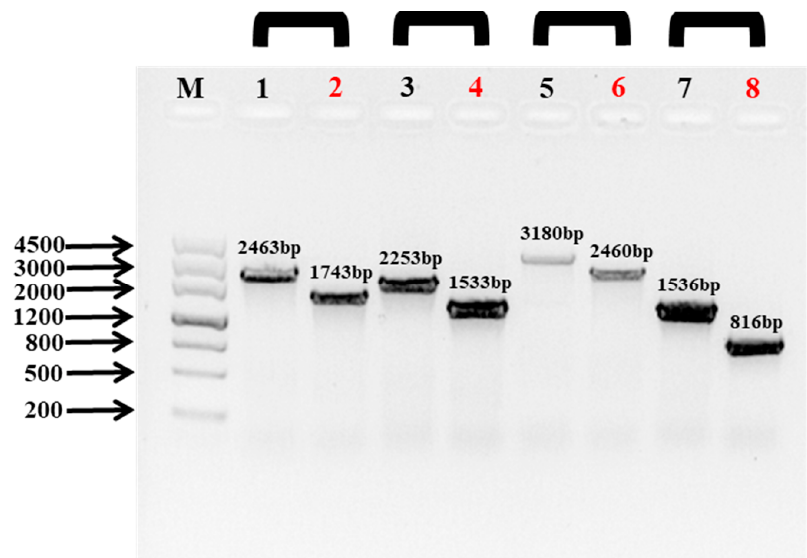
Figure 1. The deletion of the ompR gene was confirmed by PCR. M: DNA Maker Ⅲ ; Wild-type in lanes 1, 3, 5, and 7; Δ ompR in lanes 2, 4, 6, and 8. Lane 1 ( ompR -SF/LR, 2463 bp), lane 2 ( Δ ompR -SF/LR, 743 bp), lane 3 ( ompR -LF/SR, 2253 bp), lane 4 ( Δ ompR -LF/SR, 1533 bp), lane 5 ( ompR -LF/LR, 3180 bp), lane 6 ( Δ ompR -LF/LR, 2460 bp), lane 7 ( ompR -SF/SR, 1536 bp), and lane 8 ( Δ ompR -SF/SR, 816 bp).